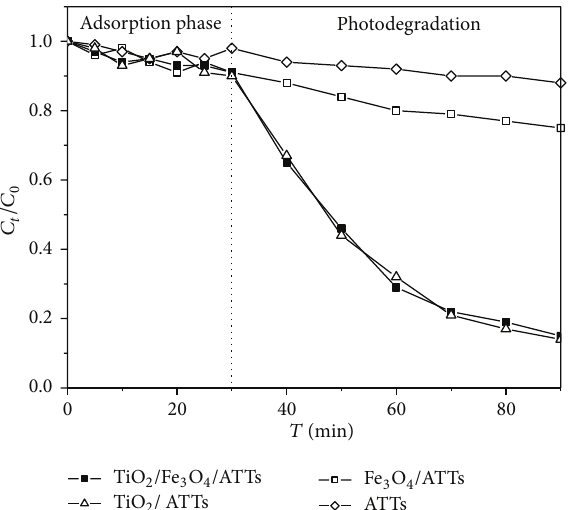
Figure 5: Photocatalytic degradation of methylene blue by bentonite, Fe 3 O 4 -bentonite, TiO 2 -bentonite, and TiO 2 -Fe 3 O 4 -bentonite under Xe light.